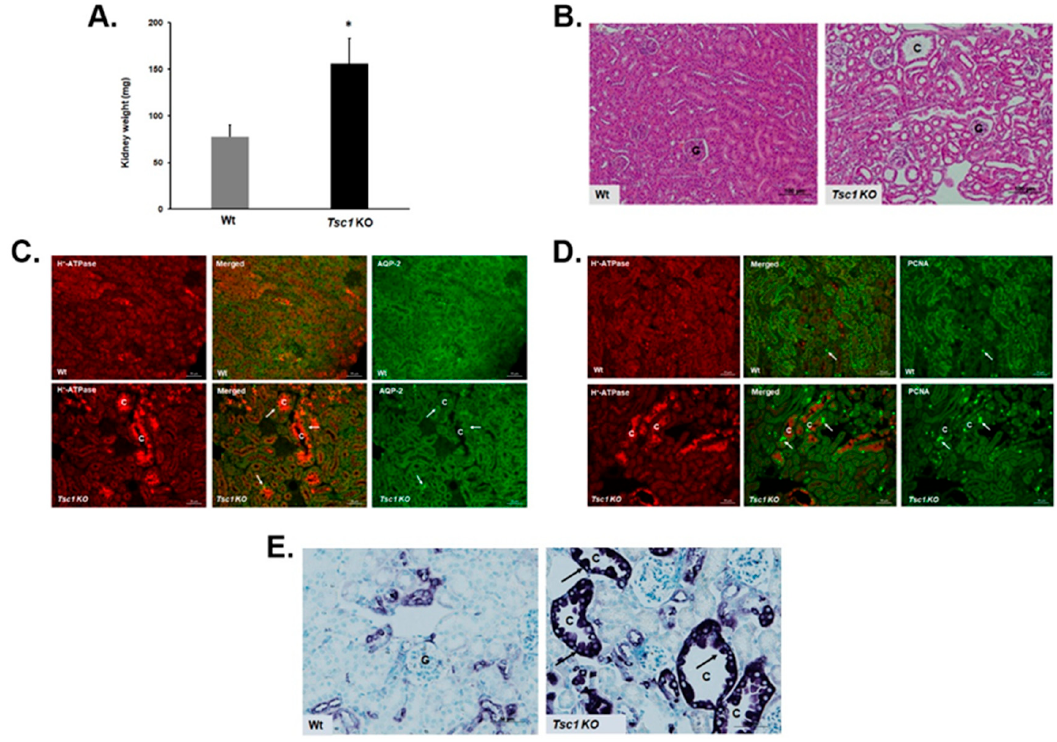
Figure 1. Characterization of kidneys from Wt and Tsc1 KO mice. ( A ) Average weight of kidneys from Wt and Tsc1 KO mice. (*) denotes a p value of equal or greater than 0.01. ( B ) Histological examination of H & E-stained kidney sections from Wt and Tsc1 KO mice for the development of cystic disease revealed the presence of numerous cortical cysts in Tsc1 KO , but not Wt mice. ( C , D ) Immunofluorescent microscopic analysis indicated that the cystic epithelium is composed of few aquaporin 2 (AQP-2)-positive principal cells ( C ; green) and is almost entirely lined with proliferatively active PCNA positive cells ( D ; green) that also express apical H ± -ATPase (red), a marker of A-intercalated cells. ( E ) Cystic epithelium strongly stained with phosphor-P70S6 kinase, a marker of mTORC1 activation. “C” represents cysts and “G” represents glomerulus.